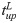
J-PET detection modules: A pair and a single layer.(A) Left panel: scheme of the pair of J-PET detection modules. Such pair constitutes a simplest detection unit capable of registration both collinearly propagating quanta resulting from electron—positron annihilation. Times of light signals arrivals to photomultipliers are denoted as: tupL—to left upper photomultiplier, tupR—to right upper photomultiplier, tdwL—to left lower photomultiplier, tdwR—to right lower photomultiplier. Red dot indicates a place of annihilation, Δz denotes the distance between the point of interaction in scintillator and the center of the strip, ΔLOR denotes the position of annihilation along the line-of-response between two strips with respect to the centre of LOR. Both Δz and ΔLOR are determined based on the measured times tupR, tupL, tdwL, tdwR. (B) Right panel: schematic visualization of an example of a single detection layer of the J-PET detector. Each scintillator strip is aligned axially and read out at two ends by photomultipliers.